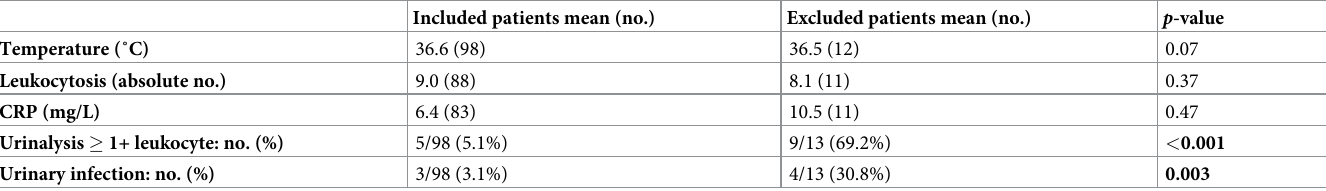
Table 3. Comparison between included patients and patients excluded with a known urogenital malformation. Included patients mean